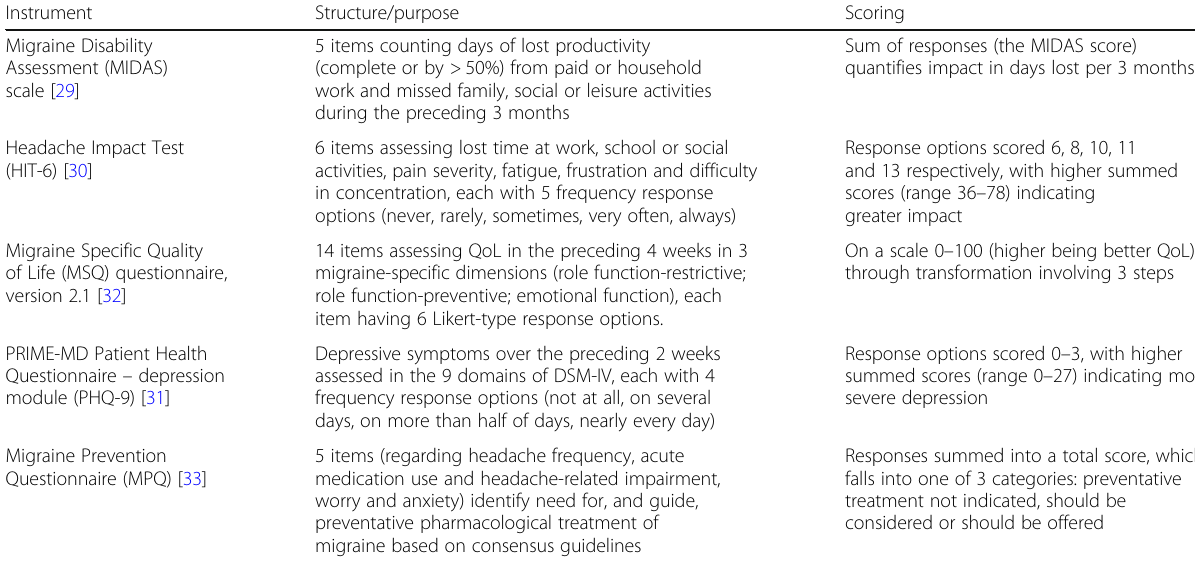
Table 3 Instruments used as external validators Instrument